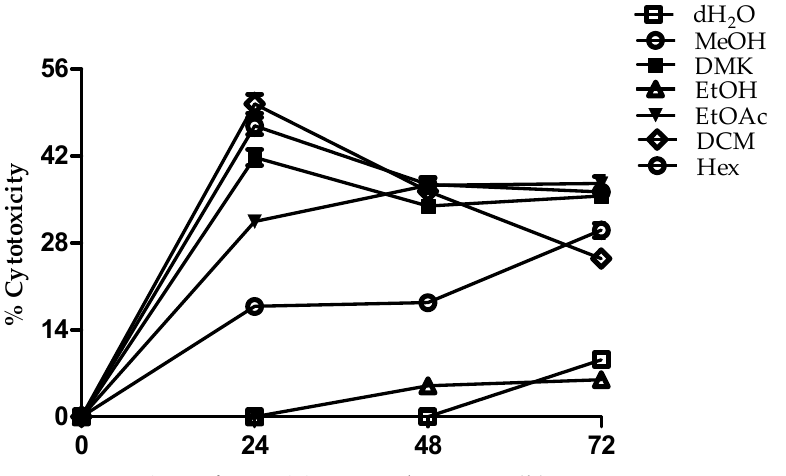
Figure 3. Cytotoxicity. B. x buttiana extracts with solvents at 100% at 26 °C for 24, 48 and 72 h were assayed to determine their effects on cellular cytotoxicity, as described in the Materials and Methods section. Each point corresponds to the results (mean ± SD) from three different preparations.